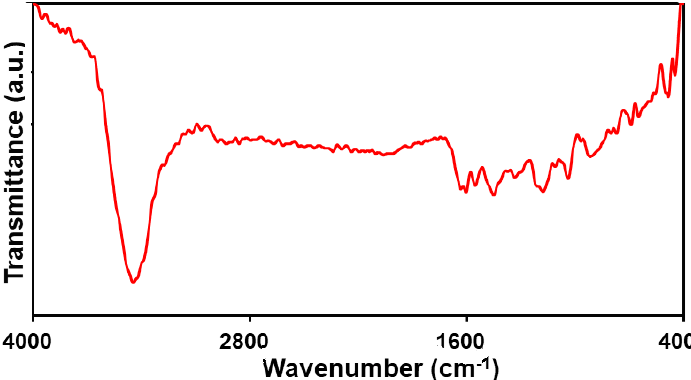
Figure 2. The FT-IR spectrum obtained of the PPy NTs.